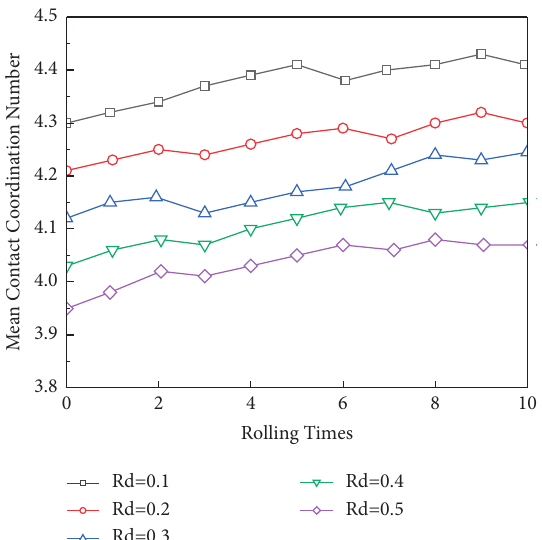
Figure 19: Mean contact coordination number-compactor pass responses for fillings with different roundnesses.